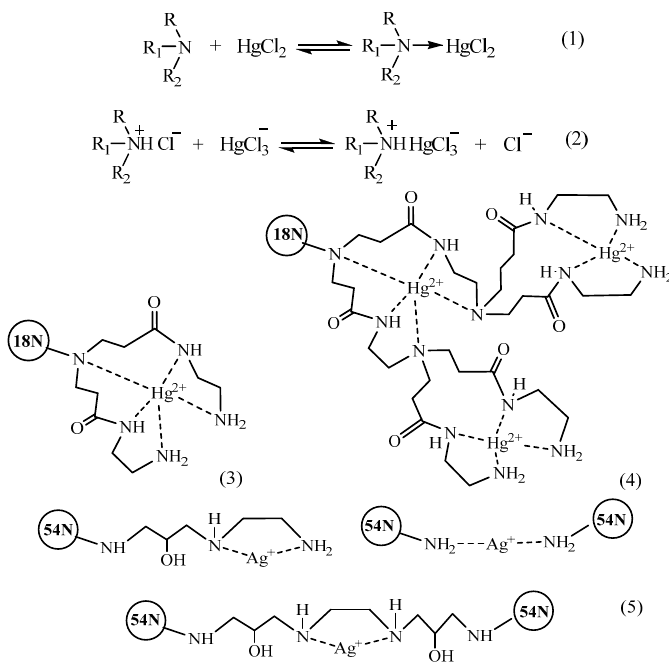
Figure 9. Suggested structures of aminated chitosan derivatives complexes with transition